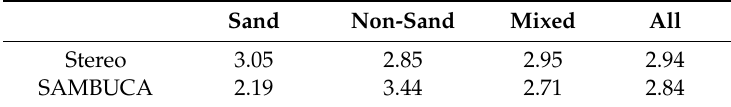
Table 3. Mean absolute error, ∆ , for sand, non-sand, mixed, and all classes for the two methods. Sand